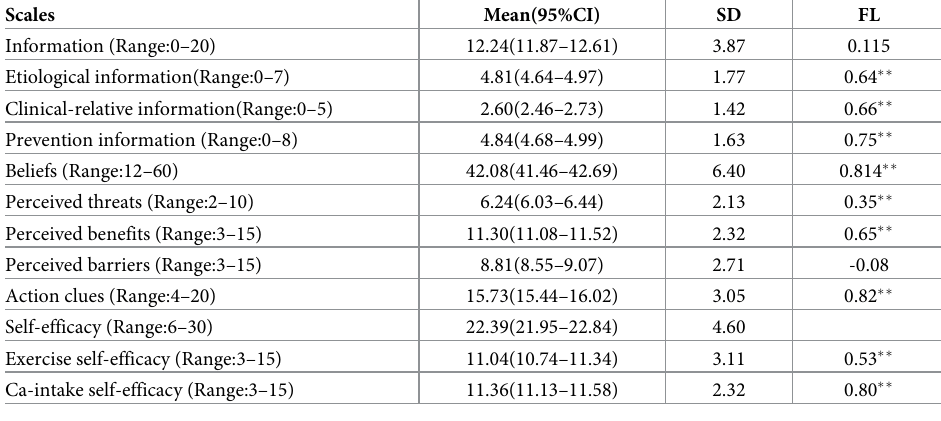
Table 3. Summary statistics and factor loadings of the HBM based on confirmatory factor analysis(N = 421).